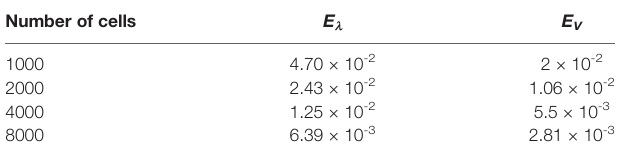
TABLE 7 | Uniform fragmentation, ex. 2, case n = 1: errors for different number of cells. Number of cells E l E V 4.70 × 10